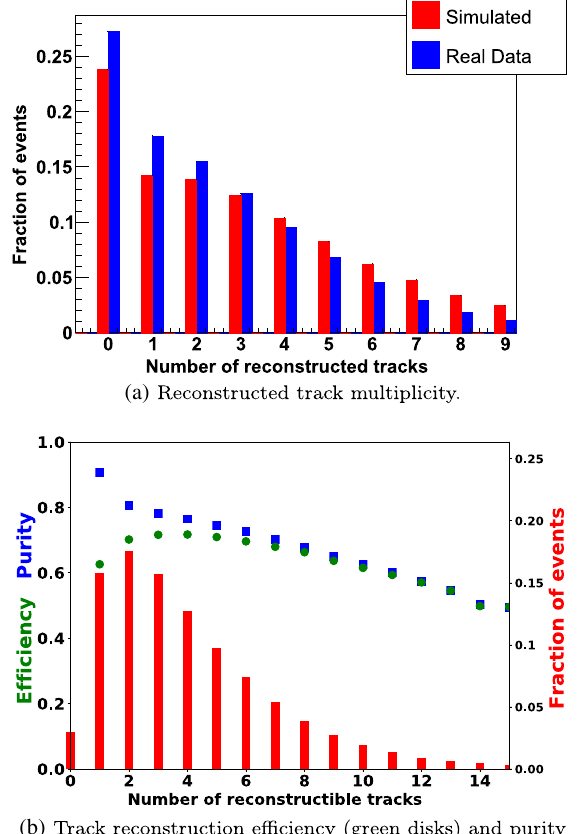
FIG. 7. Performance of the track reconstruction algorithm.